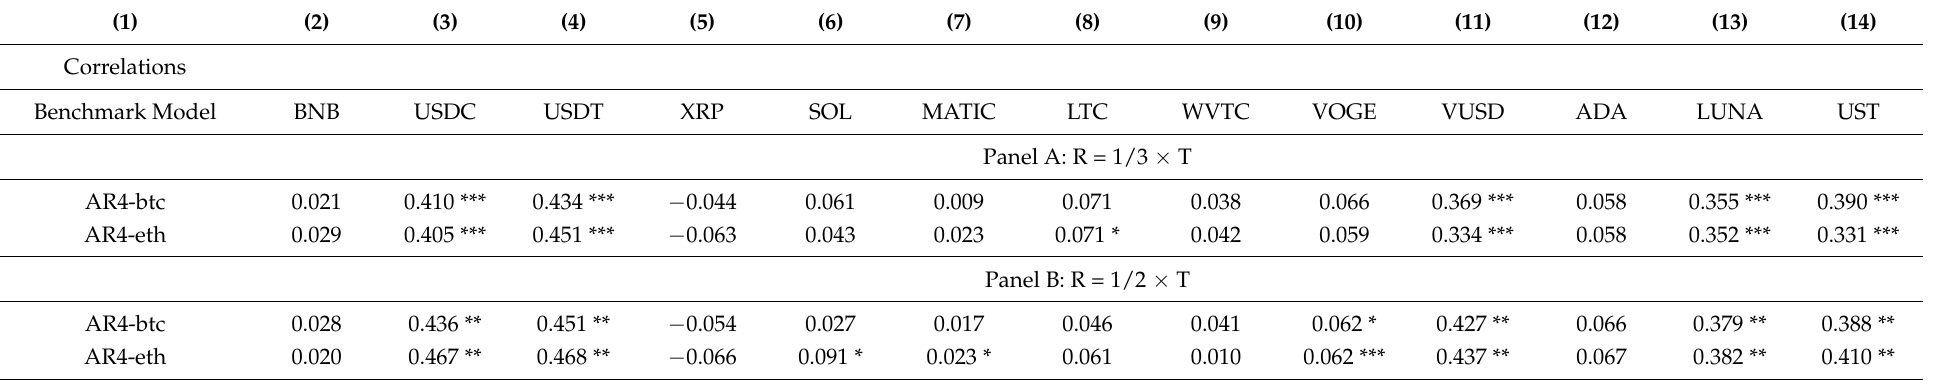
Table 6. The out-of-sample results using a correlation test for different benchmarks and estimation